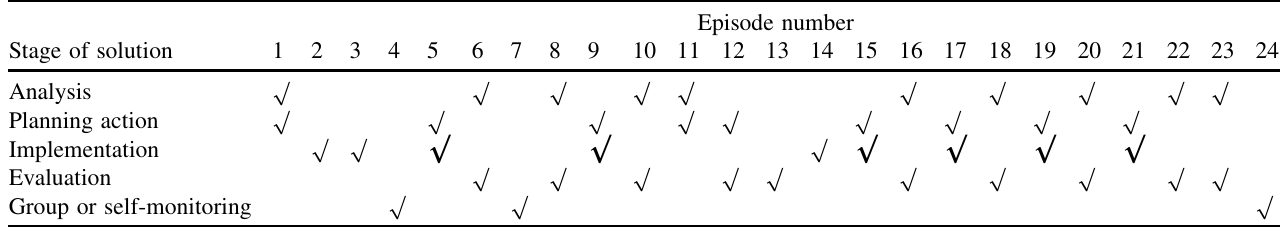
SUPPORTING TEACHERS WHO INTRODUCE . . TABLE IV. Workshop C (cognitive apprenticeship): Episodes mapped to pedagogical problem-solving steps.